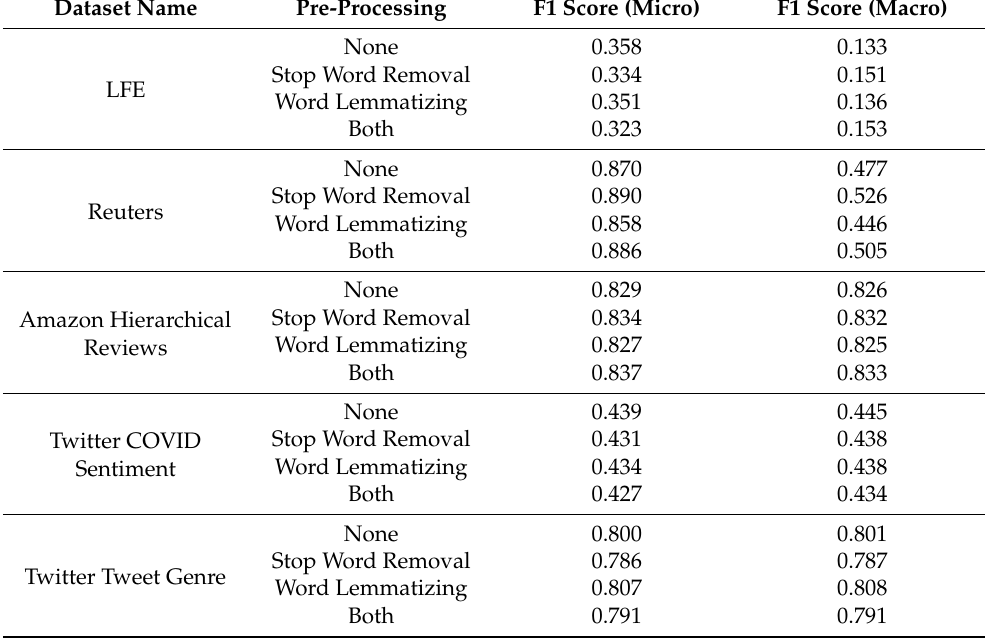
Table 3. Evaluates the effect of different pre-processing techniques on the accuracy of classification. The same processing pipeline is maintained aside from pre-processing (TF-IDF, BoW,